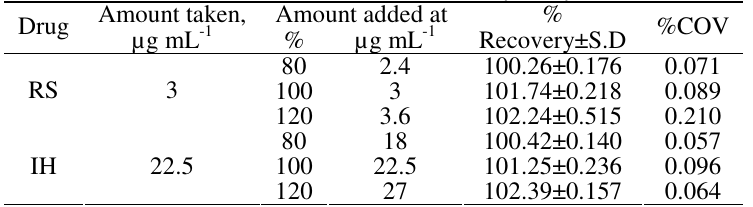
Table 2. Results from the recovery